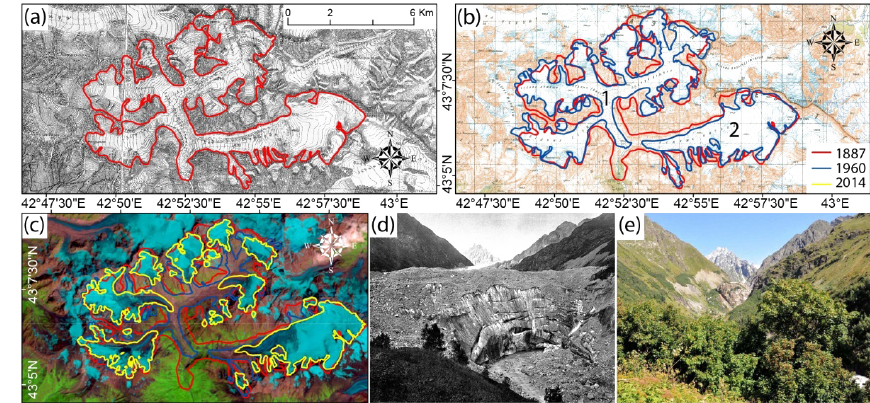
Figure 2. (a) Tviberi Glacier, topographical map 1887; (b) topographical map 1960, 1: Tviberi Glacier, 2: Kvitlodi Glacier; (c) Landsat L8 imagery; (d) Tviberi Glacier terminus in 1884 (photo by M. V. Dechy); (e) the same view in 2011 (photo by L. G.